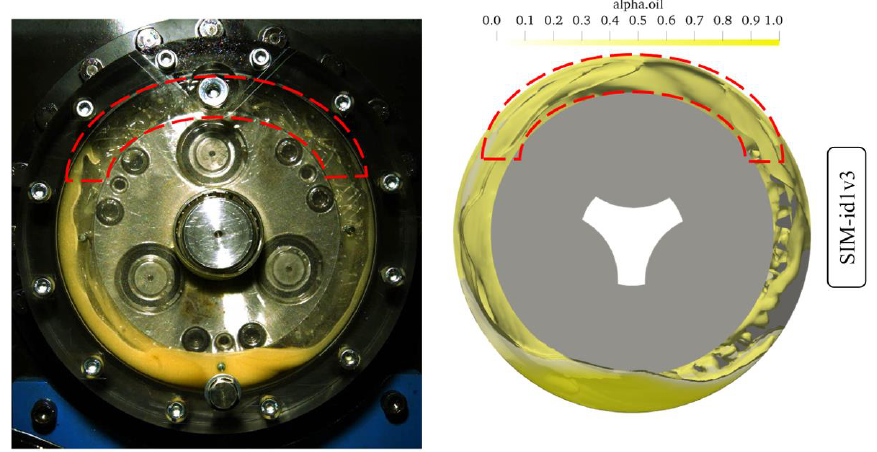
Figure 8. Experimental ( left ) and CFD ( right ) comparison of the oil flow for SIM-id1v3. For the SIM-id1v1 operating condition (Figure 6), the low rotational speed translates into a low amount of oil being dragged by the planet carrier rotation. This results in the formation of an oil track in the lower left region (red dashed rectangle) and only a small quantity is carried up by the planet carrier rotation. This behavior is well captured by the simulation. As the velocity increases (SIM-id1v2, Figure 7), more oil is dragged by the planet carrier. This reflects into higher splashing on the left area (red dashed rectangle), as well as into a pronounced oil ejection on the right side of the gearbox (blue dashed dot rectangle). Both phenomena are very well predicted by the CFD model. At the highest velocity (SIM-id1v3, Figure 8), the centrifugal forces promote a marked radial expansion of the oil towards the housing, also including the region above the planet carrier (red dashed arc). However, the simulation predicts a greater amount of oil in the upper region. A possible explanation for this difference could be related to the modeling of wall adhe- sion at the contact point between the wall surface and the interface, as explained in Section 2.4.4. These three operating conditions were investigated by Liu et al. [2] as well. Moreo- ver, in their model, the planet carrier rotation drags the oil from the sump and brings it to the upper part of the system. It was observed that the higher the rotational speed, the higher the amount of oil being splashed around. The fact that their model includes the bearings can introduce some differences in the small-scale flows in that region. Dedicated sub-models with a much finer mesh around the bearings and specific boundary conditions for the correct description of the rings’ and rollers’ kinematics would be necessary to accu- rately predict the oil flow and the velocity and pressure gradients in the bearings region [35]. Figures 9 – 11 show a side-by-side comparison for the high filling level operating con- ditions.